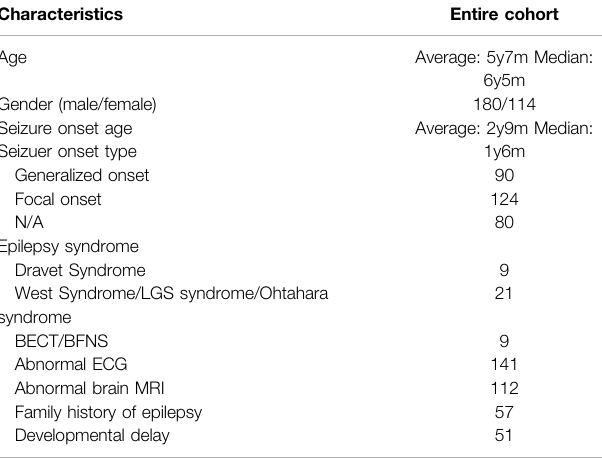
TABLE 1 | Demographic data of the childhood epilepsy